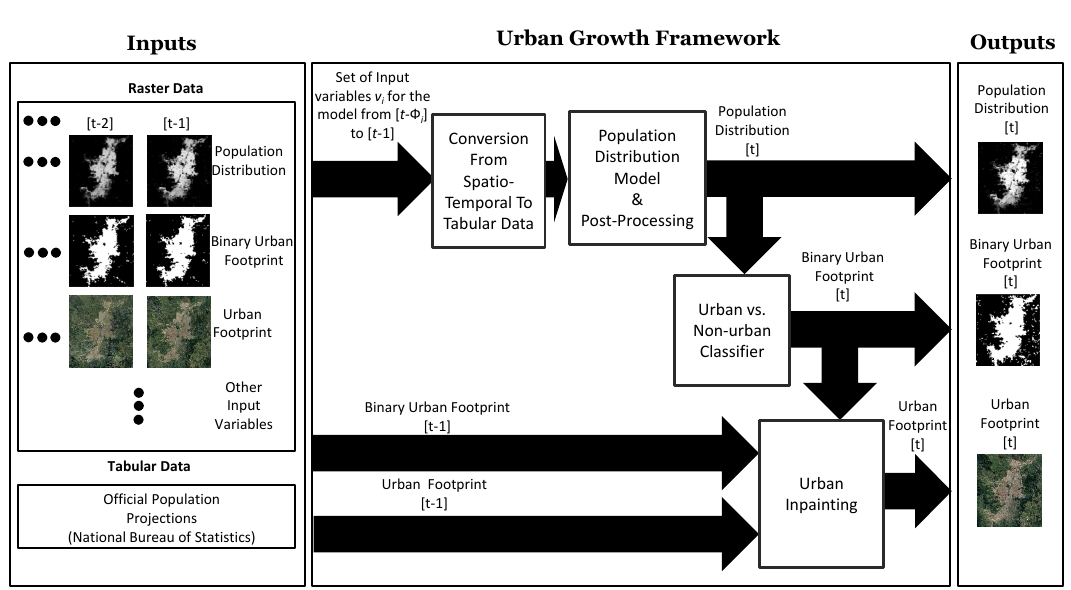
Figure 7. Interaction among the three key variables of the urban growth framework: population distribution, binary urban footprint, and urban